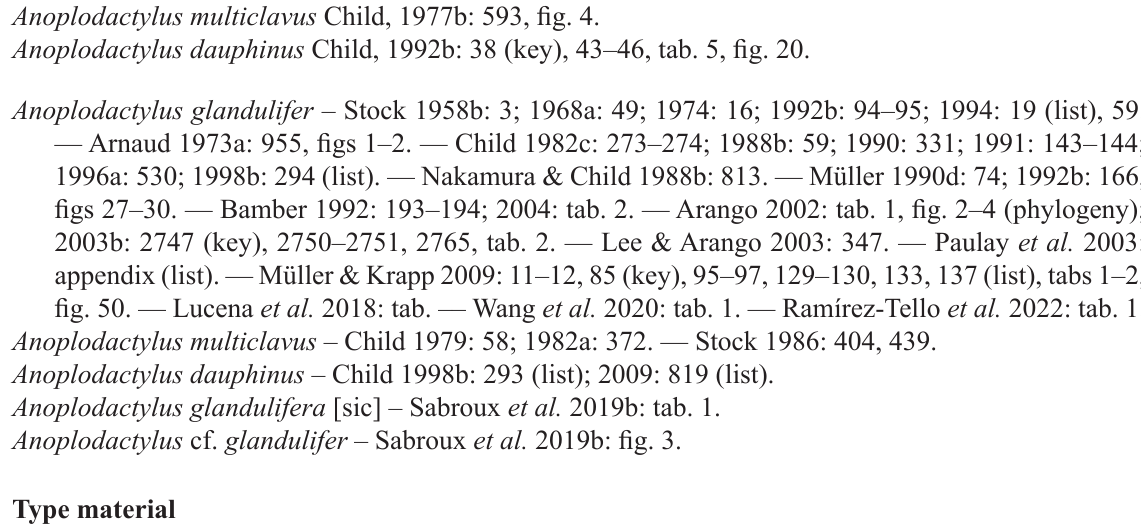
fig. 50. — Lucena et al. 2018: tab. –– Wang et al. 2020: tab. 1. — Ramírez-Tello et al. 2022: tab.